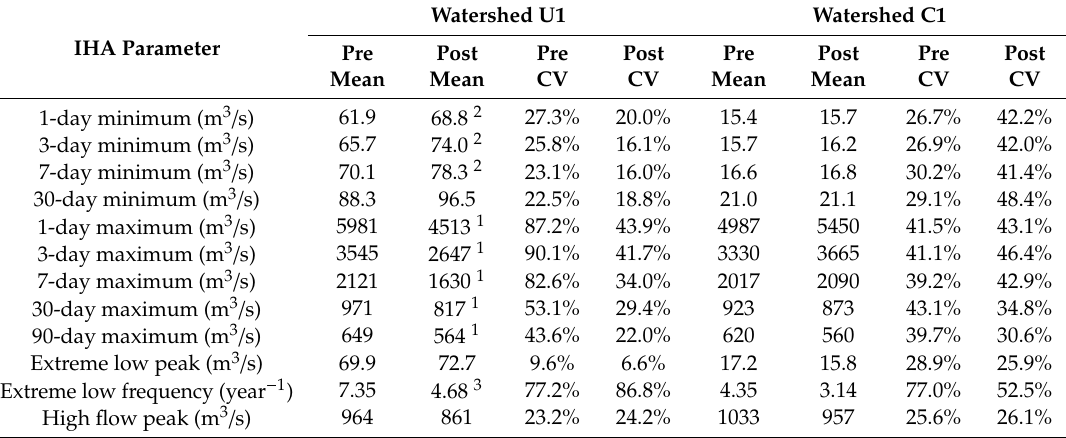
Table 3. Results of two-period Indicators of Hydrologic Alteration (IHA) analysis with positive change in mean values indicating an increase after urbanization for watersheds in Alabama. Coe ffi cients of variation (CV) are given for the before (Pre) and after (Post) urbanization periods. Footnotes indicate the significance level of the trend from one period analysis. Only parameters with a significant trend for at least one watershed are